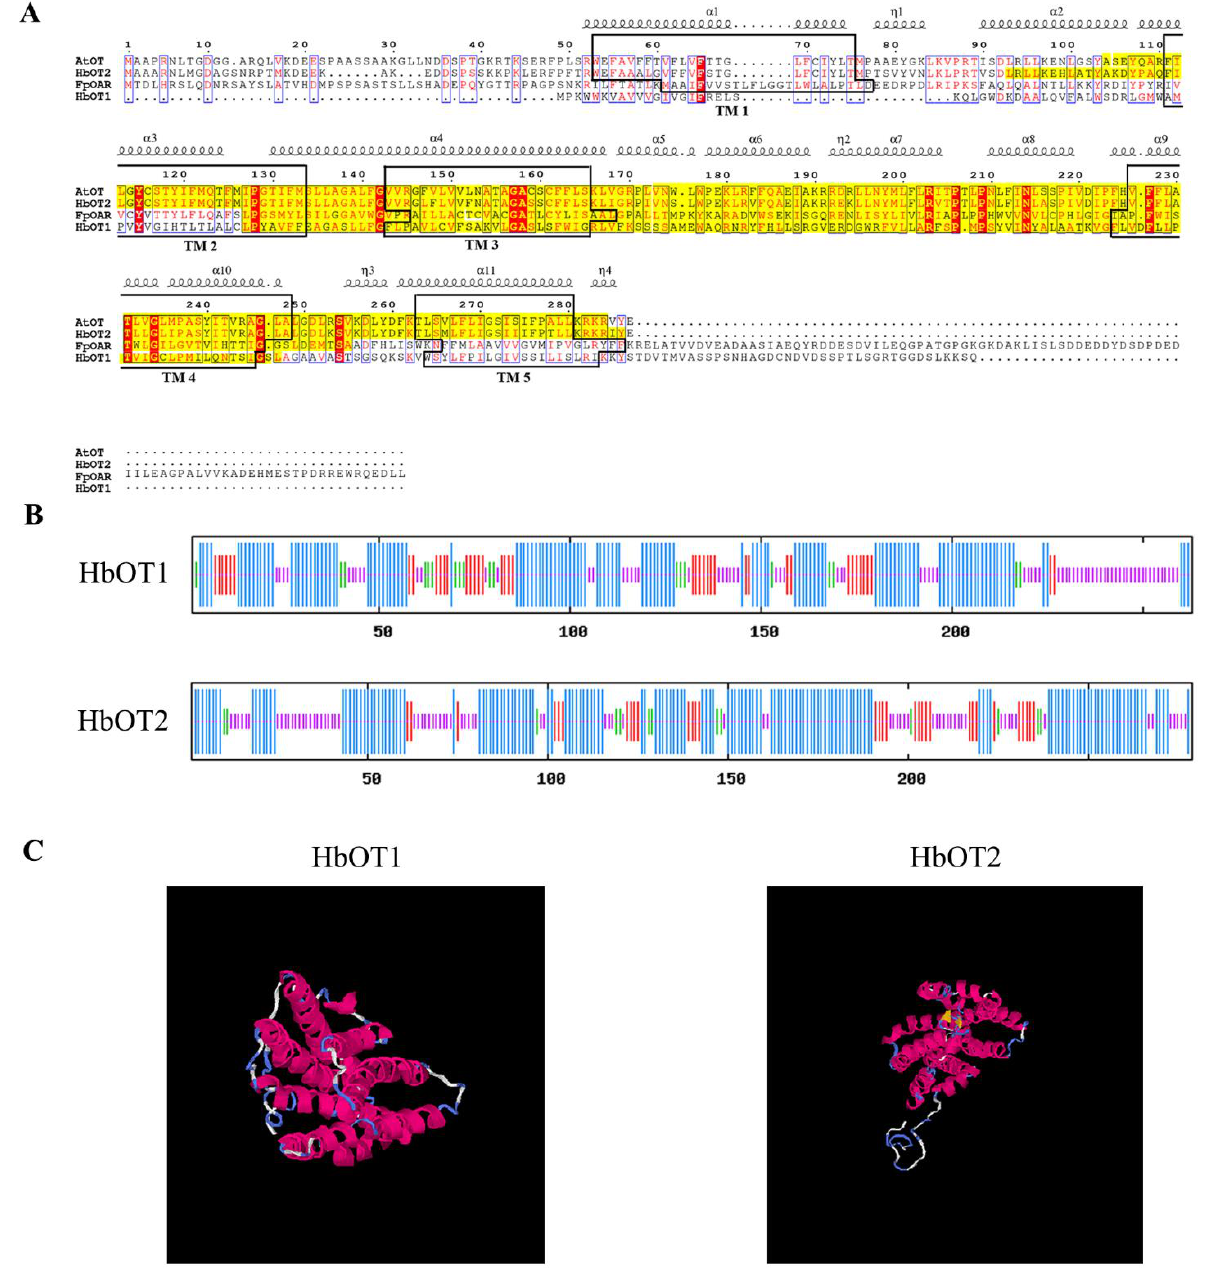
Figure 2. Multiple sequence alignment and protein structure analysis of HbOT1 and HbOT2. ( A ) Multiple sequence alignment of FpOAR, HbOT1, HbOT2, and AtOT. Different secondary structures are labeled above a specific sequence, the black boxes represent the transmembrane domains (TM1-TM5) of the protein, and the yellow highlighted fragment represents the SNARE_assoc conserved domain of the protein. Conserved and similar residues are identified by red shadows and blue boxes, respectively. ( B ) Prediction for the secondary structure of HbOT1 and HbOT2 by NOS@SOPMA. Each bar represents an amino acid, with blue for α -helix, red for extended strand, green for β -turn, and purple for random coil. ( C ) Prediction for the tertiary structure of HbOT1and HbOT2 by I-TASSER.